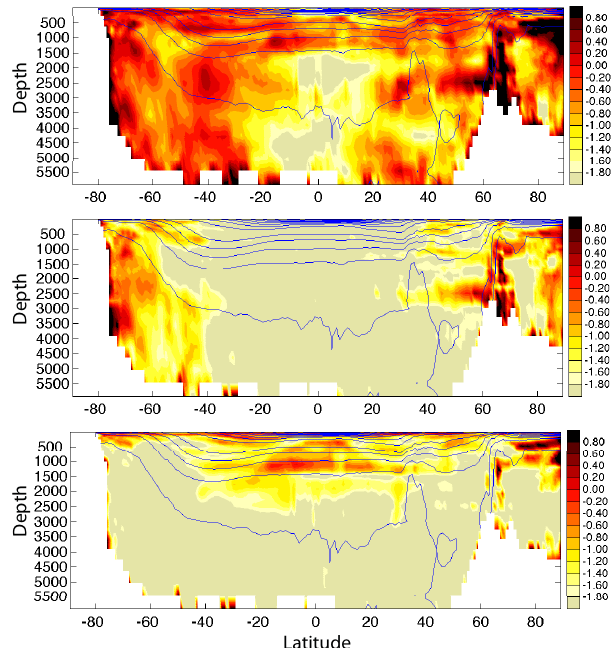
Figure 7. Sensitivity of ocean stratification to K gm (top), K σ (mid- dle), and K d (bottom). Mean squared deviations are computed be- tween perturbation experiments and the state estimate for the 2008– , and then normalized by the cor- 2010 monthly climatology of ∂ρ Figure 8. Mixed layer depth sensitivity (color shading) to K gm ∂z responding state estimate variance. The color shading shows the (top), K σ (middle), and K d (bottom). Computational and plotting log 10 of this ratio. Thus, orange denotes > 10% differences, while details are similar to Fig. 7. Overlaid blue contours (resp. magenta dark red denotes > 100% differences. The perturbation experiment contours) denote the 60, 70, 80, 90th (resp. 10, 20, 30, 40th) per- where the K gm (resp. K σ , K d ) estimate is reset to the constant K σ centiles of the observed mixed layer depth map (mld (x,y ) from the (resp. K σ , K d ) first guess is shown at the top (resp. middle, bottom). bottom right panel of Fig. Overlaid contours: zonal mean potential density from the OCCA at- las.